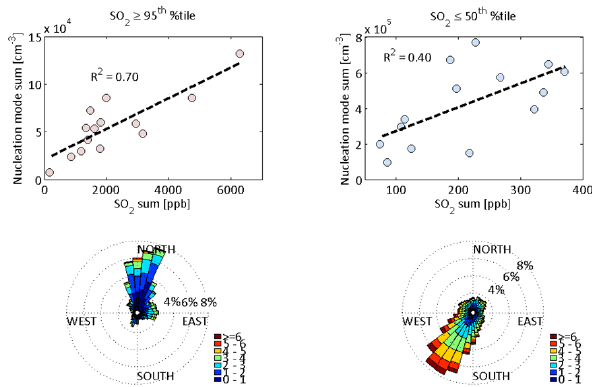
Fig. 13. Yearly sum of nucleation mode particle concentration as Figure 1314 Yearly sum of nucleation mode particle concentration as a function of yearly 2 a function of yearly sum of SO 2 for polluted (SO 2 >overall 95th sum of SO 2 for polluted (SO 2 > overall 95 th percentile) and clean (SO 2 < overall median) data 3 percentile) and clean (SO 2 <overall median) data and linear fits to and linear fits to them. Corresponding wind roses are plotted below. The color scale is the 4 them. Corresponding wind roses are plotted below. The colour scale is the wind speed in ms − 1 , and the percentages shown in roses are wind speed in m/s and the percentages shown in roses are fractions of the all (clean or 5 fractions of the all (clean or polluted) data. polluted) data. 6